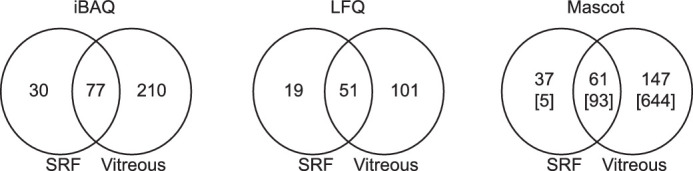
Venn diagram of iBAQ, LFQ, and Mascot analyses. For iBAQ and LFQ, data rely on quantification in a minimum of 75% of the samples in each group. For the Mascot qualitative analysis, the proteins were identified in a minimum of 50% of the samples in each group. The numbers in squared brackets define proteins identified in the minimum half of the SRF group and any of the samples in the vitreous control group.